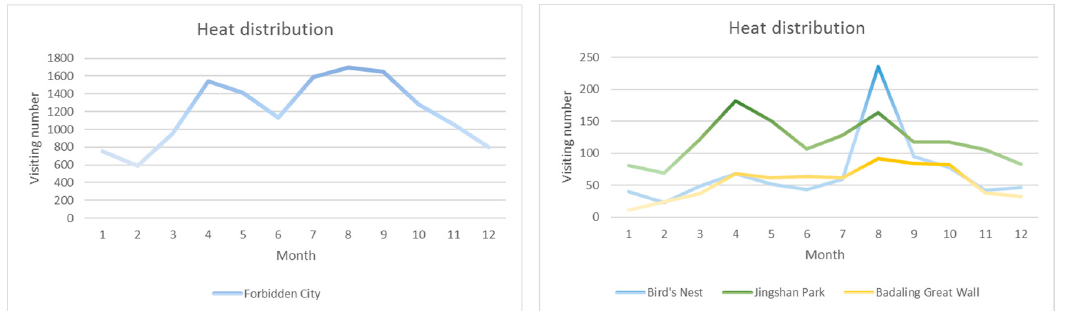
Figure 15. Heat distribution map divided by months.